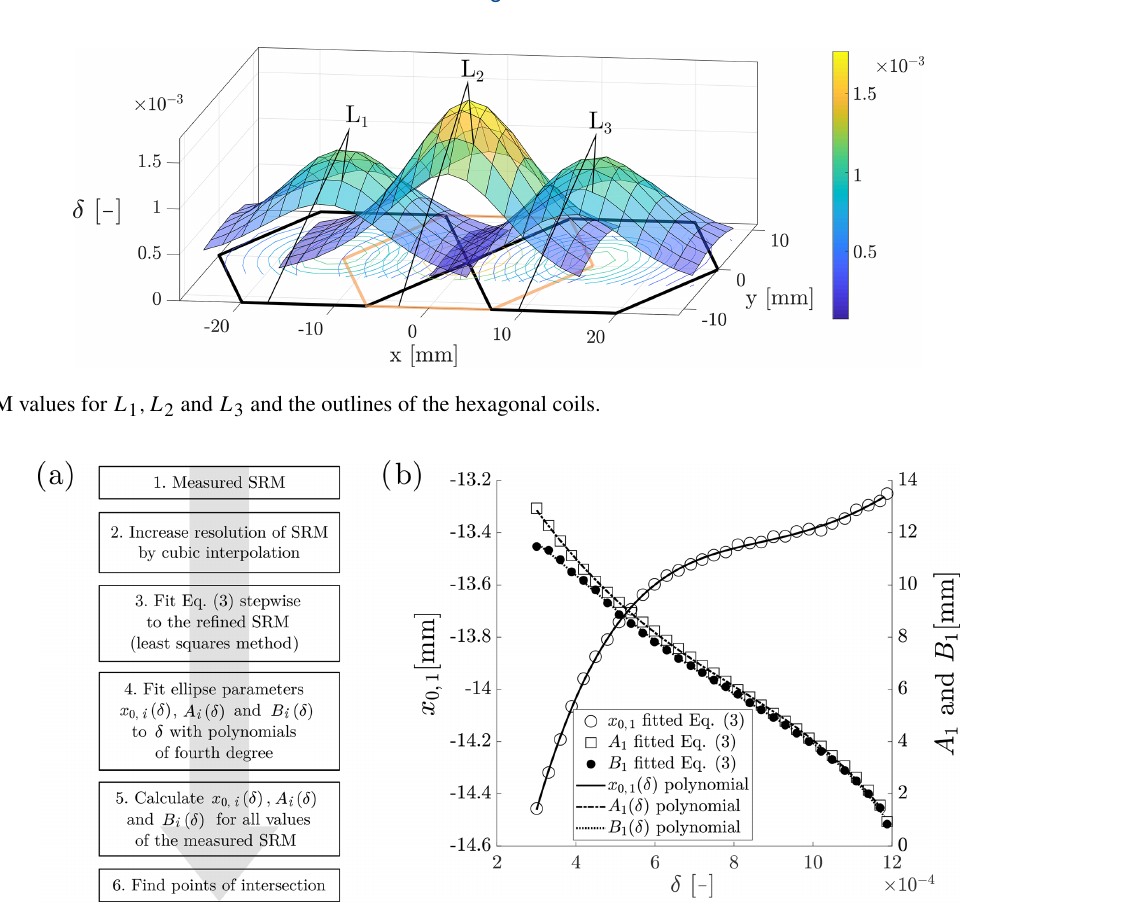
Figure 5. (a) Stepwise data processing for a determination of the x position. (b) Stepwise fitted Eq. (3) and fitted polynomials (Eq. 4) for the ellipse parameters regarding L 1 .